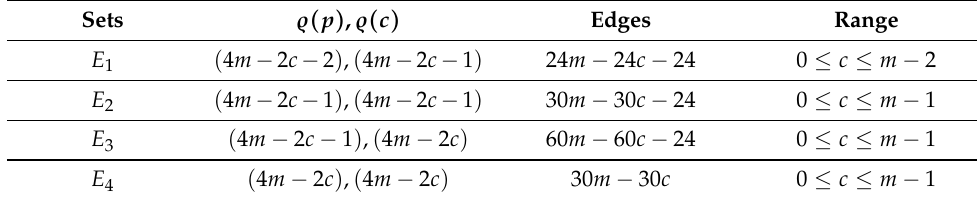
Table 2. Edge Partition of POH ( m ) . Sets (cid:36) ( p ) , (cid:36) ( c ) Edges Range E